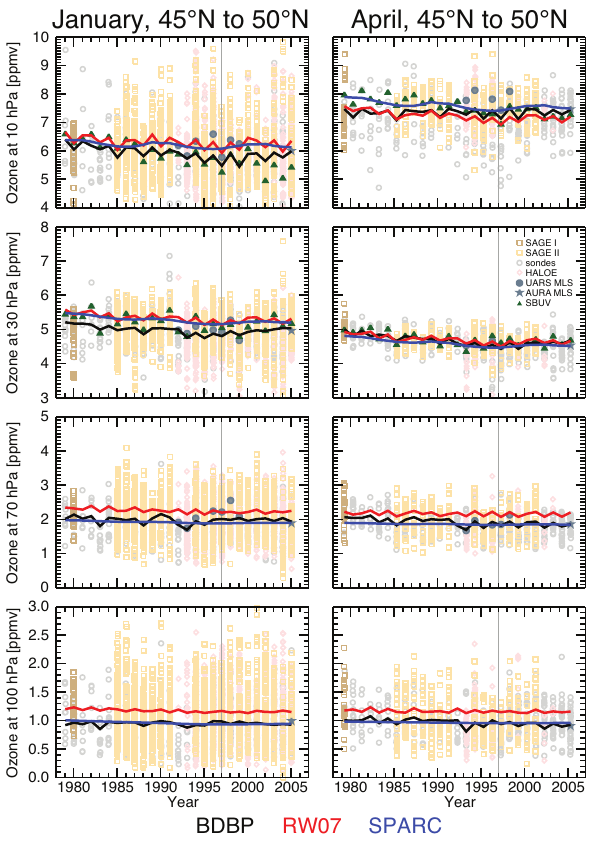
Fig. 5. January (left) and April (right) ozone time series 45 ◦ N to 50 ◦ N for four different pressure levels. Individual ozonesonde measurements available in this zone are shown for these months (grey open circles), together with SAGE I and II (orange open squares), HALOE (red open diamonds), and SBUV/SBUV2 (dark green, filled triangles), UARS MLS monthly means (dark grey, filled circles), AURA MLS monthly means (dark grey, filled stars), and the BDBP (Tier 1.4, black), RW07 (red) and SPARC (blue) time series are shown. The vertical grey line denotes the inflection point selected for piecewise linear trend calculations (see Section 6).